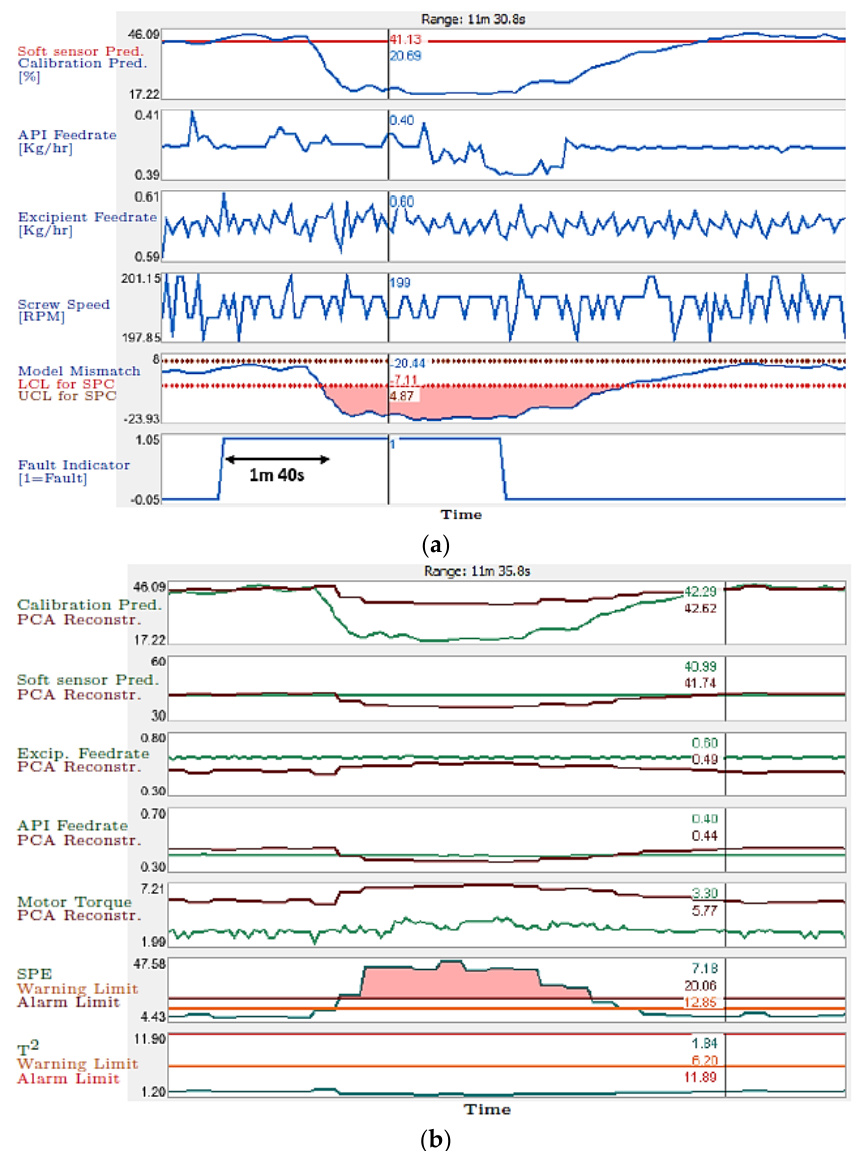
Figure 5. ( a ) SPC data, ( b ) PCA data SPE and T2. (Reproduced with permission from Tahir et al., computer and chemical engineering; published by Elsevier, 2019) [41].